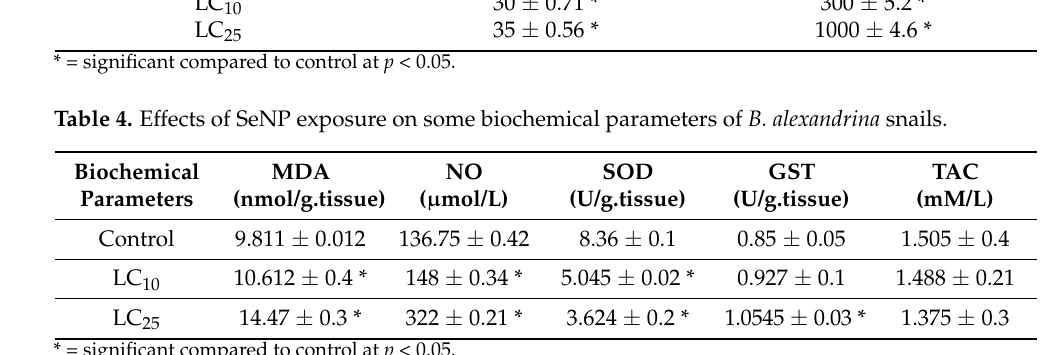
Table 3. SeNP exposure effects on (T) and (E2) concentration of B. alexandrina snails .